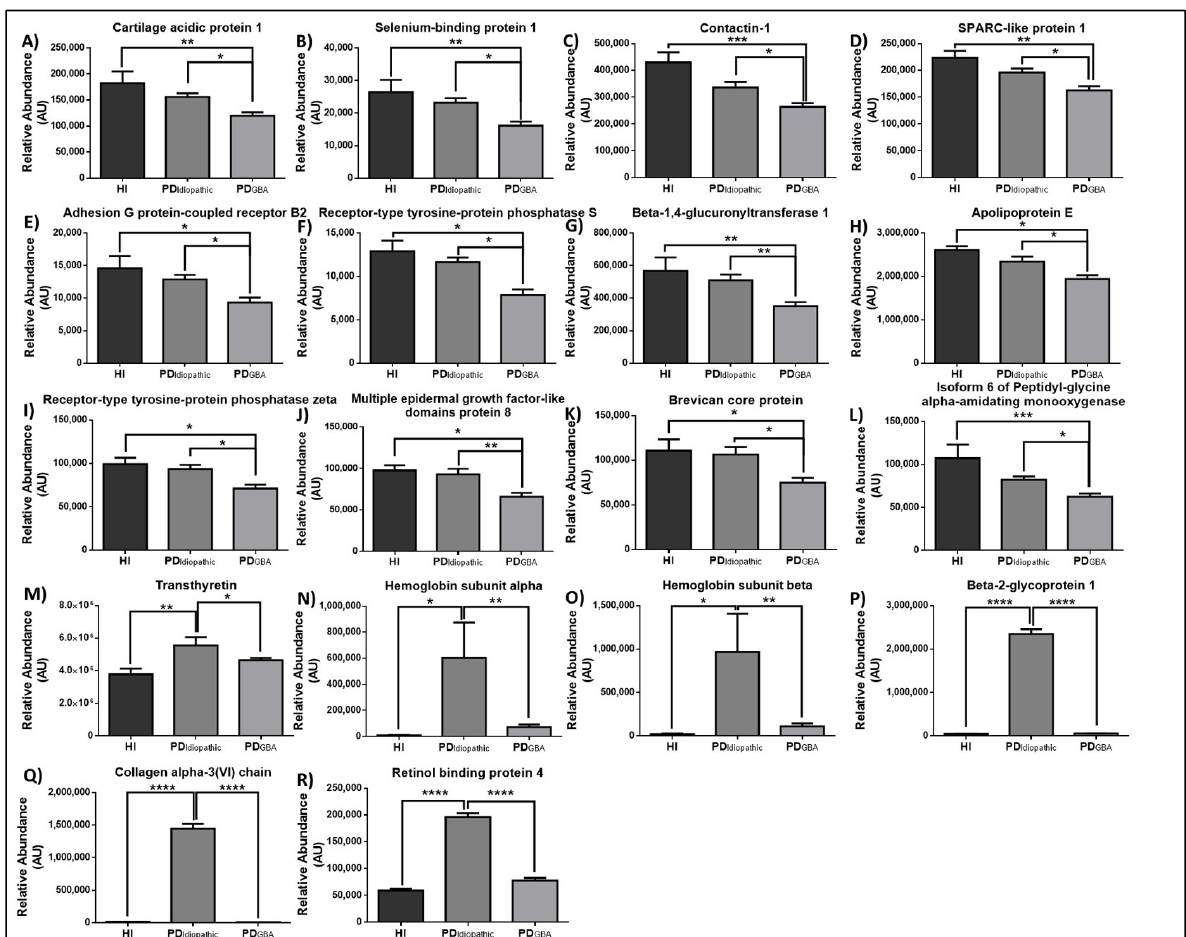
Figure 2 . Relative CSF concentrations of the proteins differentially regulated in PD Idiopathic vs PD GBA cases . The graphs depict the relative amount of ( A ) Cartilage acidic protein 1, ( B ) Selenium-binding protein 1, ( C ) Contactin 1, ( D ) SPARC-like protein 1, ( E ) Adhesion G Protein-Coupled Receptor B2, ( F ) Receptor-type tyrosine-protein phosphatase S, ( G ) Beta-1,4-glucuronyltransferase 1, ( H ) Apolipoprotein E, ( I ) Receptor-type tyrosine-protein phosphatase zeta, ( J ) Multiple epidermal growth factor-like domains pro- tein 8, ( K ) Brevican core protein, ( L ) Isoform 6 of Peptidyl-glycine alpha-amidating monooxygenase, ( M ) Transthyretin, ( N ) Hemo- globin subunit alpha, ( O ) Hemoglobin subunit alpha, ( P ) Beta-2-glycoprotein 1, ( Q ) Collagen alpha-3(VI) chain and ( R ) Retinol bind- ing protein 4 in HI, PD Idiopathic , and PD GBA cases. One-way ANOVA, followed by Tukey’s multiple comparisons test, was used for statistical analysis. Error bars represent SEM. (* p ≤ 0.05; ** p ≤ 0.01; *** p ≤ 0.001; **** p ≤ 0.0001).